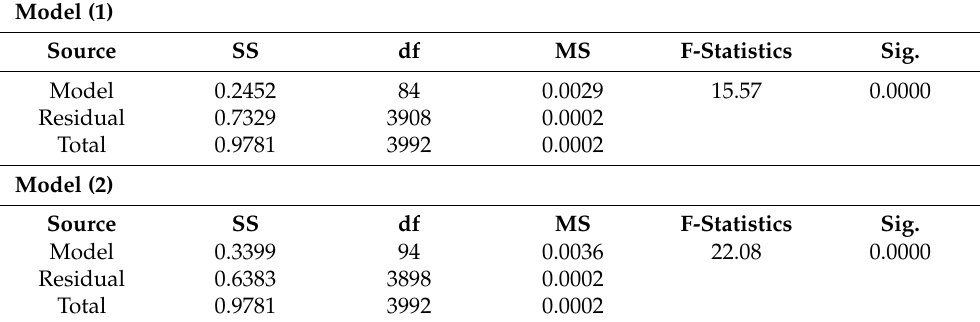
Table 7. Analysis of variance